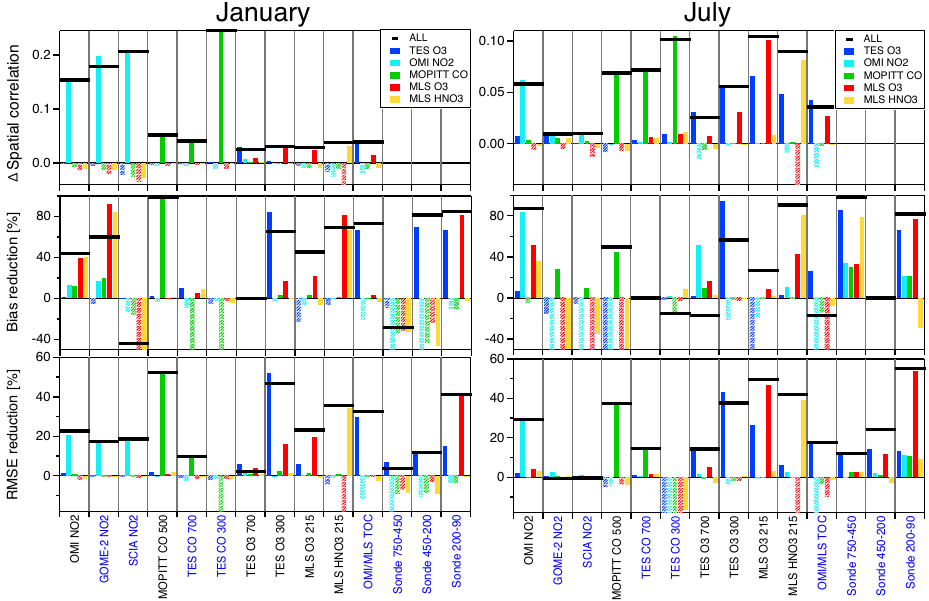
Fig. 5. The differences in the global spatial correlation, the global mean bias, and the global RMSE between the data assimilation runs and the control run for the 16–30 (from the 7–30 only for the ozonesondes) of January (left) and July (right) in 2007. These scores are first estimated from the comparison against observations listed at the bottom (assimilated data in black and independent data in blue), and then compared with the control run. For the spatial correlation, the difference (the data assimilation runs minus the control run) is positive (negative) when the spatial correlation is higher (lower) in the data assimilation runs than in the control run. For the bias and the RMSE, the error reduction rate defined by Eq. (7) is plotted; the positive (negative) value represents that the error is smaller (larger) in the data assimilation runs than in the control run. A reduction rate of 100% indicates that the error in the model is completely removed by the data assimilation. The results are shown for six different data assimilation runs (the full assimilation run and the five OSEs). The number shown in the bottom list represents the approximate altitude level in